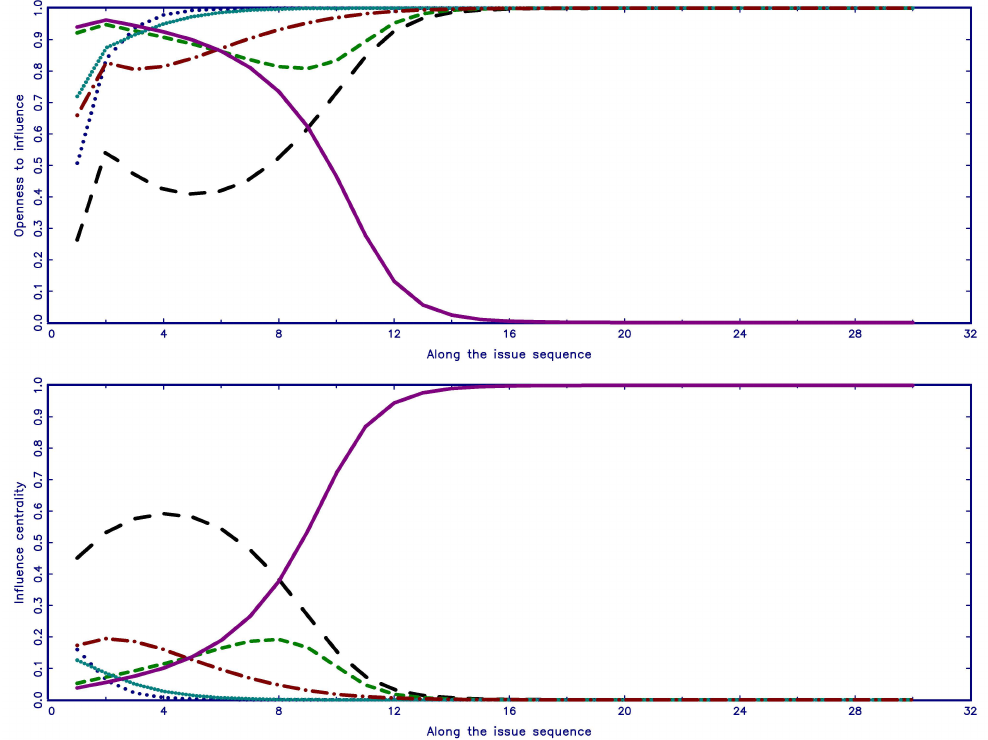
Figure 1: Illustration of the predicted evolution in a n = 6 group with a stable strongly connected structure of relative interpersonal influences. Along the sequence of issues s = 1, 2, . . . , the reflection mechanism alters members’ levels of openness to influence on issue s + 1 in correspondence with their prior influence centrality on issue s of the sequence. The top panel plots the changing levels of individuals’ levels of openness to influence. One member moves toward complete closure and all others move toward complete openness. These adjustments elevate or dampen the strength of individuals’ allocated influences to others. The bottom panel plots the associated changes of influence centrality. One member moves toward maximal centrality and all others move toward minimal